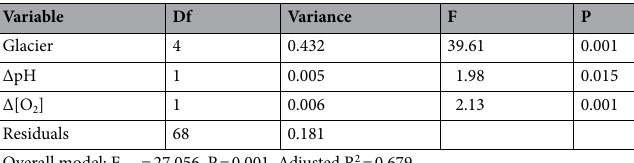
Variable Df Variance F P Glacier 4 0.432 39.61 0.001 ΔpH 1 0.005 1.98 0.015 Δ[O 2 ] 1 0.006 2.13 0.001 Residuals 68